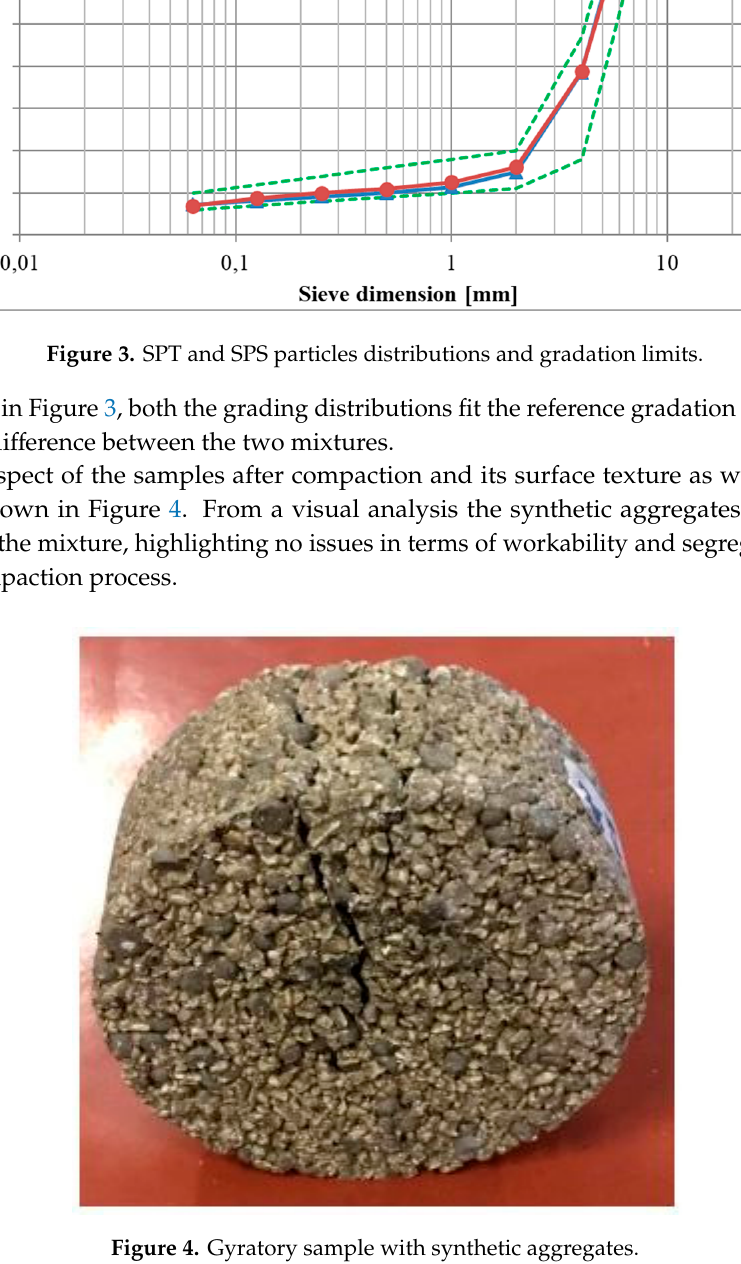
( c ) Figure 2. Pale limestone aggregates ( a ), synthetic aggregates ( b ) and transparent polymeric binder ( c ). The synthetic aggregates were sieved in order to substitute only the natural aggregate particles with the same dimensions (6.3/12.5 mm). Therefore, the gradations of the two mixtures were kept constant in order to have comparable grading curves (Figure 3). After several laboratory trials, the